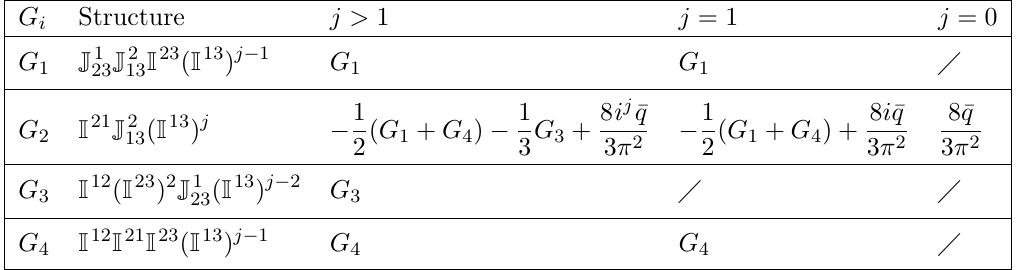
( QO ) SO when QO has h i